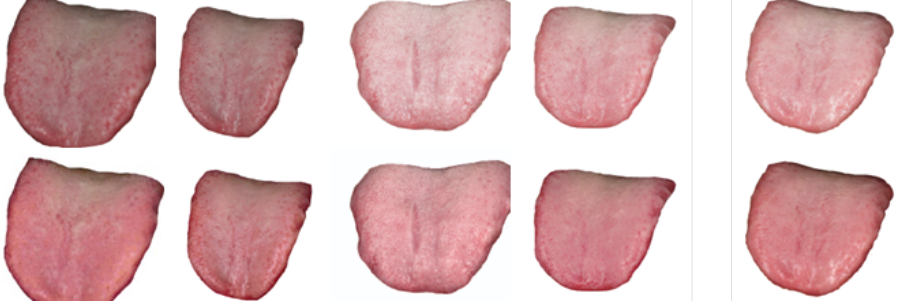
Figure 7. The captured tongue images (upper row) and their corrected results (bottom row) under five different illuminations. From left to right, they are captured under ILL1 to ILL5.